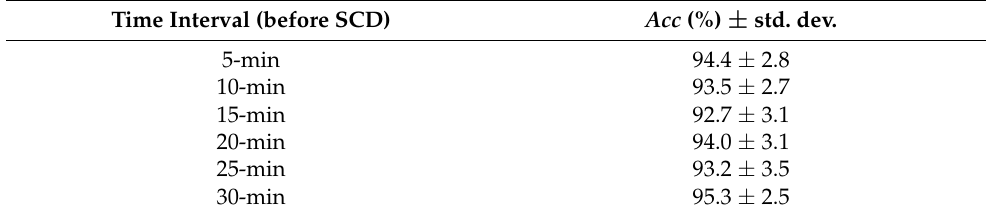
Table 3. Measures for the ten tests of ECG SCD classification through sparse